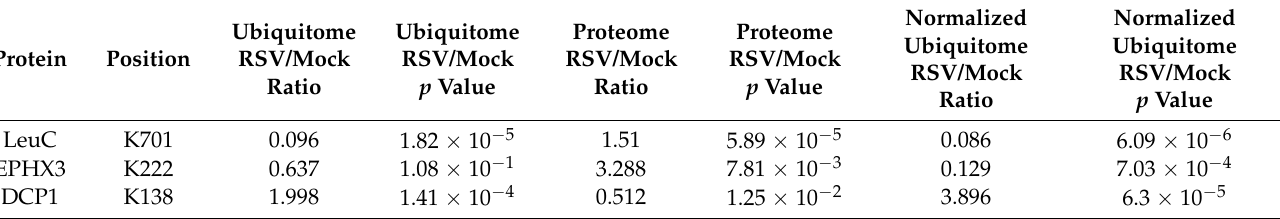
Table 3. Detailed information of chosen proteins with